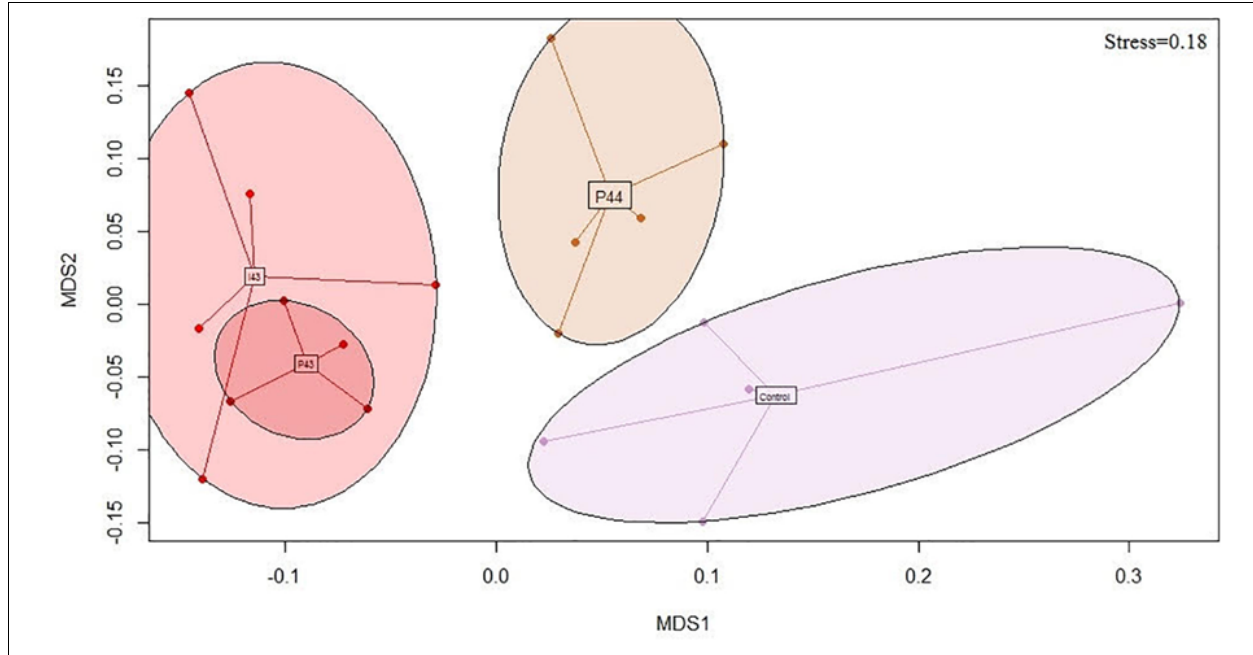
FIGURE 2 | Bray-Curtis nMDS projection of the fecal microbial communities of the kits monitored by sequencing the 16S rRNA genes at weaning (stress = 0.18). Only the groups that tend to be different from the controls (i.e., p < 0.1) are represented: P44 shows the kits exposed to the fecal pellets of the donor Doe44; I43 and P43 show the kits exposed to the microbial suspensions and the pellets of the donor Doe43, respectively; the control kits are kits raised in standard conditions.